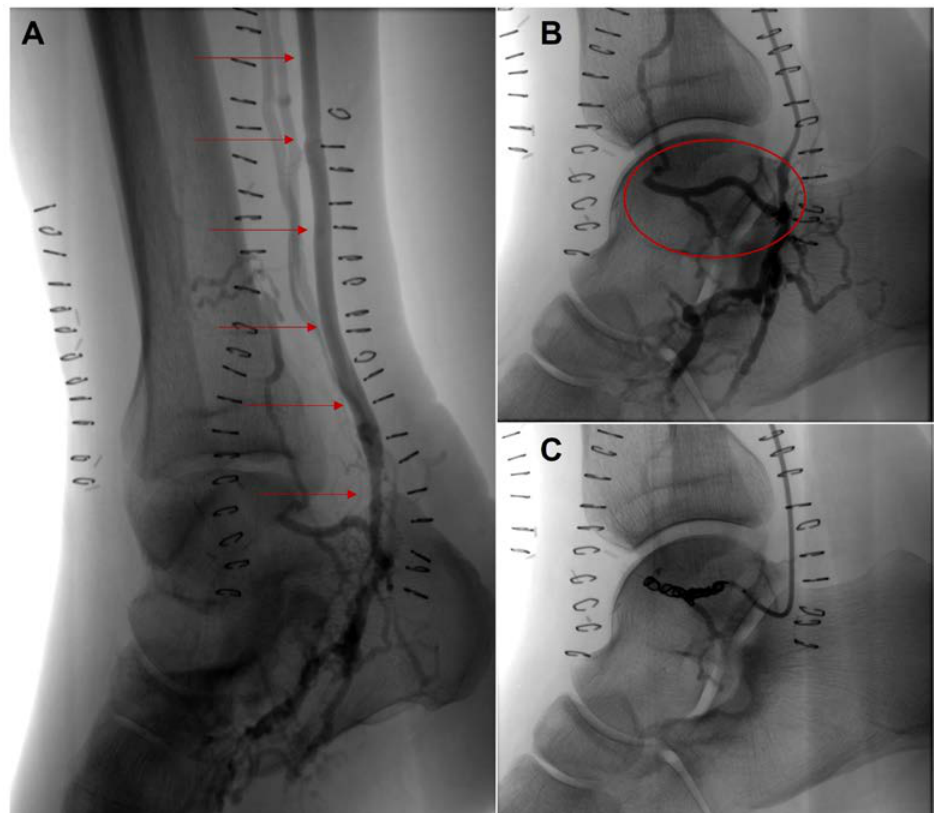
Figure 3. Angiography study of the right lower limb after open deep vein arterialization. ( A ), patent venous graft (red arrows) and excellent discharge of the bypass over the plantar veins. ( B ), a large venous collateral (red ellipse), responsible for early wash-out to leg venous vessels ( C ), coiling embolization of the large venous collateral.